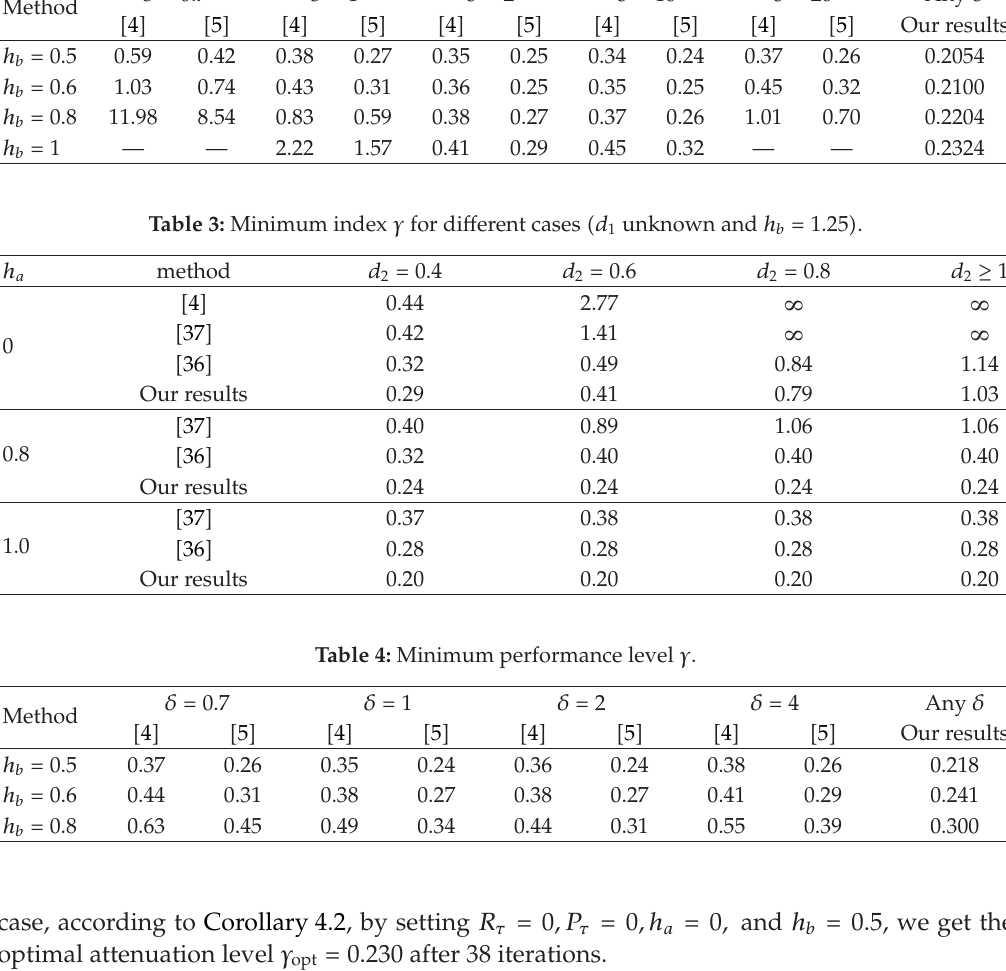
h a (cid:7) 0 (cid:4) .